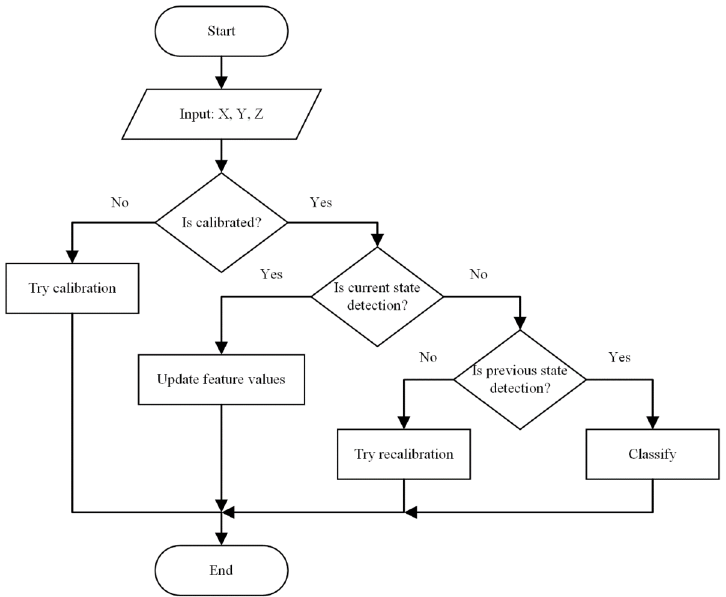
Figure 3. The flowchart of the proposed vehicle classification algorithm.